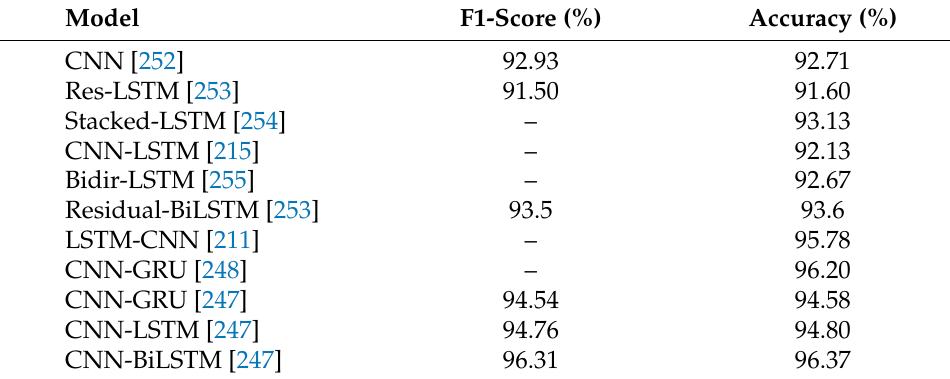
Table 3. Comparison of models on UCI-HAR dataset.